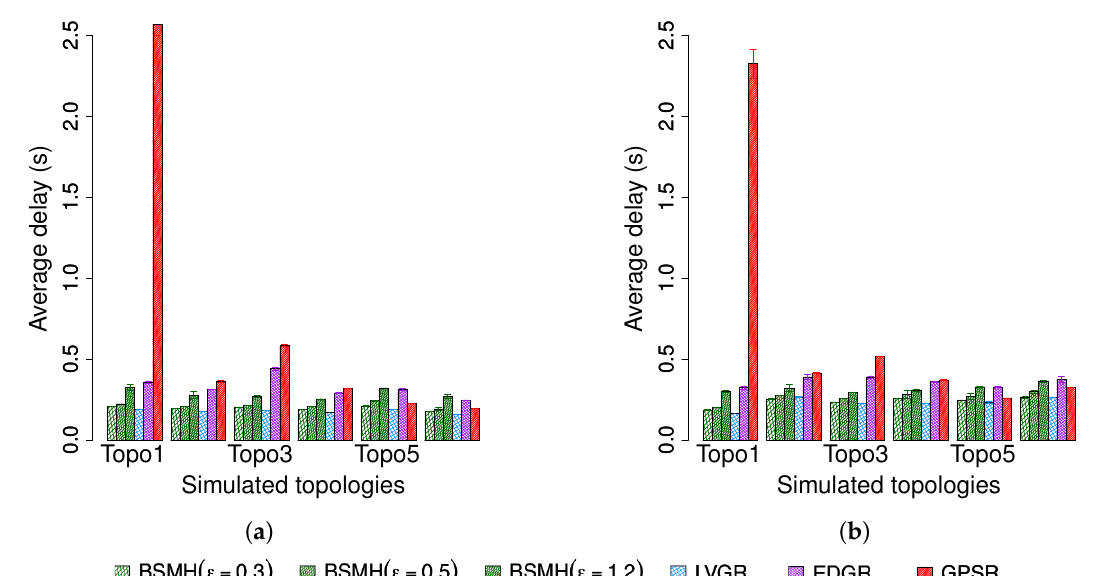
Figure 14. Average end-to-end delay of successfully delivered packets. ( a ) 1-n communication. ( b ) n-n communication.